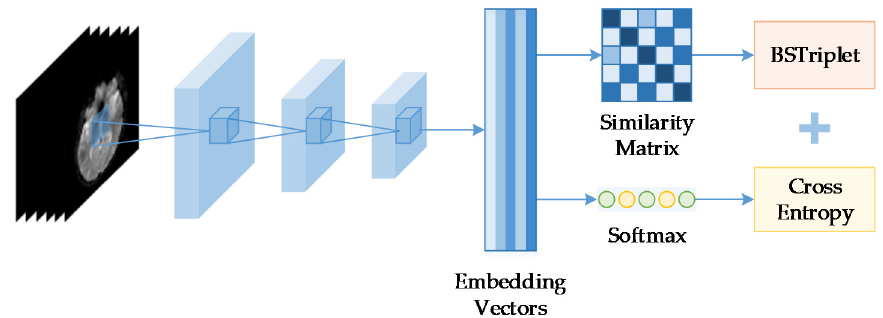
Figure 1. Framework of a convolutional neural network (CNN) trained by batch similarity-based triplet loss and cross entropy.